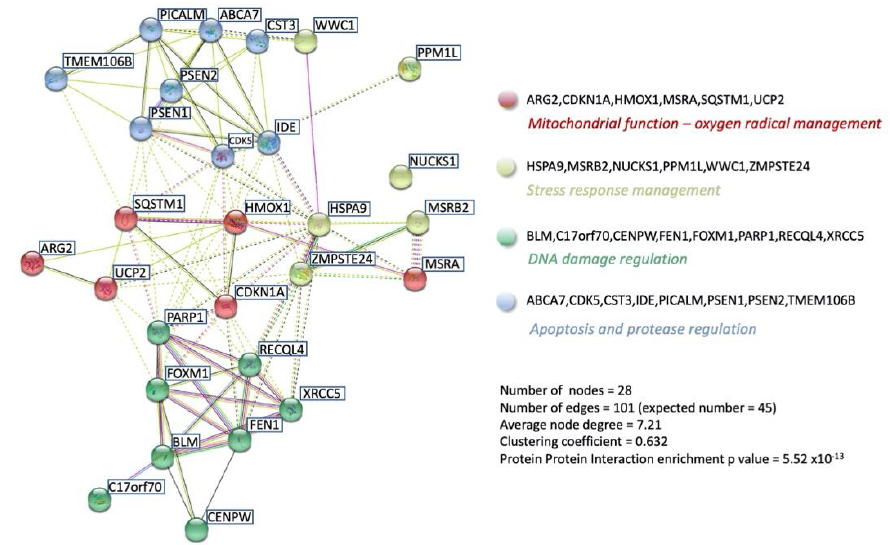
Figure 5. STRING network analysis of GPR19-Aging specific intersection data cohort. The STRING protein association database was used, along with k-means clustering, to assemble the 28 input proteins of the GPR19 total dataset with the aging-specific dataset (Figure 4), to create a functional classification of these 28 proteins as a coherent group. The k means clusters were color-coded by the STRING protein-protein-interaction (PPI) algorithms. The reported PPI enrichment probability of this 28-protein cohort was p = 5.52 × 10 − 13 .